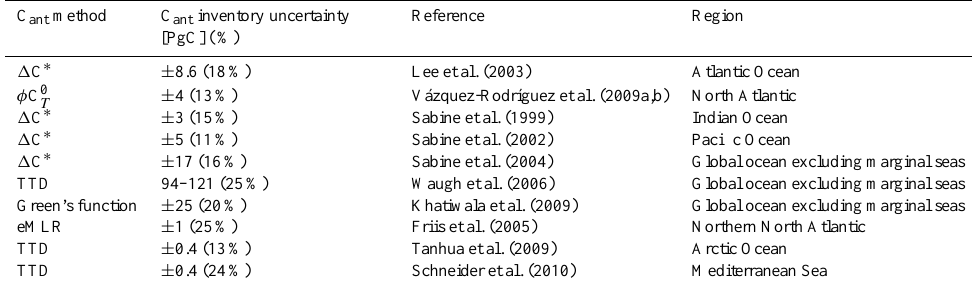
Table A3. Published estimates of uncertainty in the inventory of C ant . Numbers in bracket indicate the relative uncertainty.